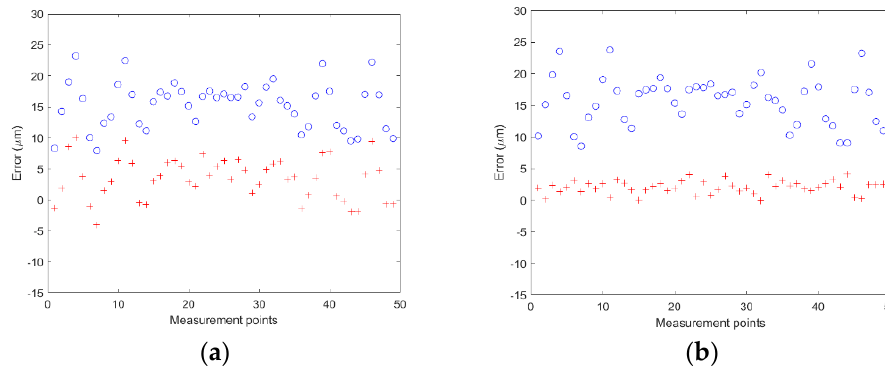
Figure 11. ( a ) The error distribution of replica one before (blue circles) and after (red plus signs) tool radius compensation for Surface two; ( b ) the error distribution of replica one before (blue circles) and after (red plus signs) mirror compensation for Surface two.